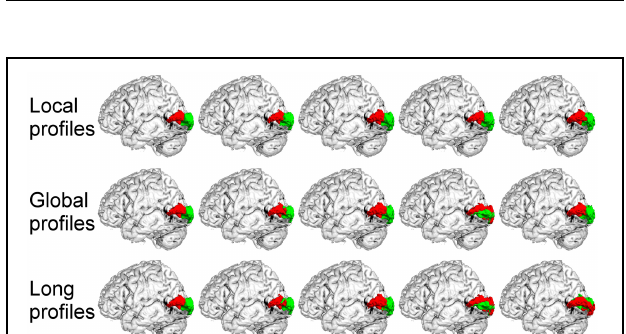
FIGURE 6 | The primary auditory cortex (A1) in the left hemisphere was parcellated into three subregions using local, global, and long connectivity profiles. The MPM from dataset 1 of the A1 (first column) and four individual example results using local, global, and long connectivity profiles are shown.